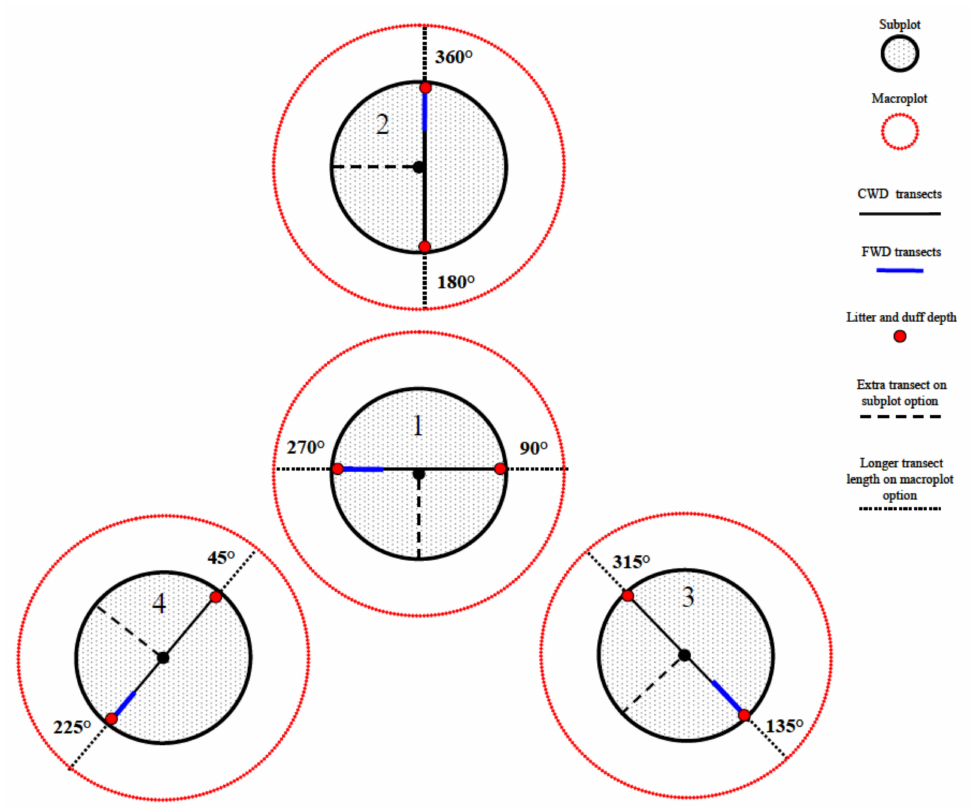
Figure 1. Downed woody material (DWM), duff, and litter transect sampling layout for Interior West Forest Inventory and Analysis (FIA) Phase 2 plots covering a single condition class. Each individual subplot (1–4) has a fixed radius of 7.3 m and each DWM transect is 7.3 m in length. Diagram reproduced from FIA National Core Field Manual